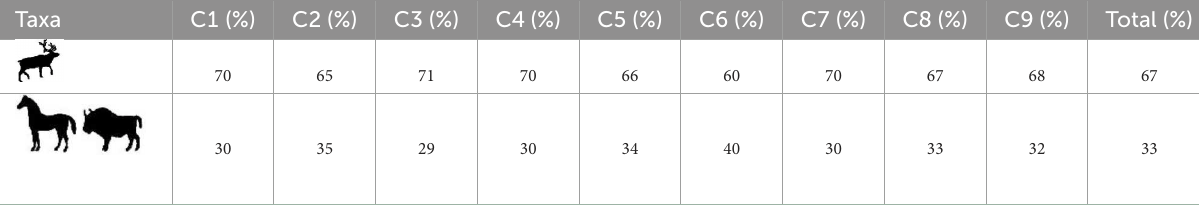
TABLE 2 Relative contribution of the different ungulate size classes to the Fauna spectrum per decapage (C1 to C9).